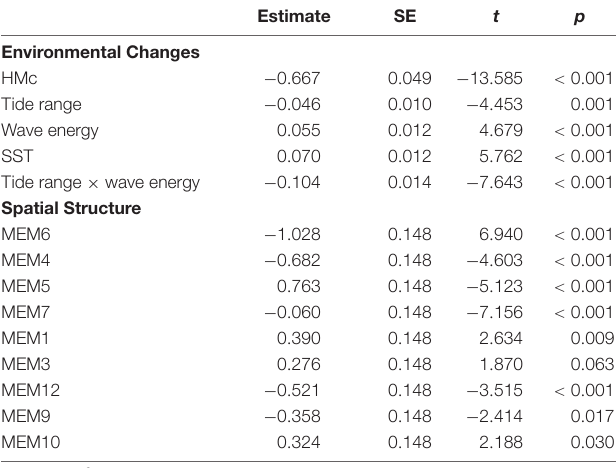
TABLE 2 | Summary statistics of the final best model relating the 214 records of burrows density of the ghost crab Ocypode quadrata from 94 sandy beach sectors from Western Atlantic coast, environmental variables, HMc values and spatial